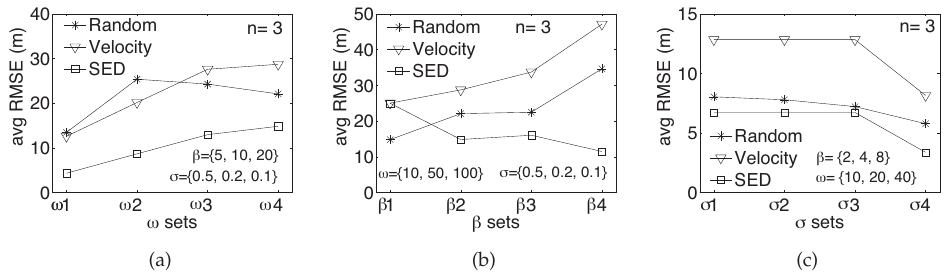
Figure 11: Average RMSE for nested evaluation of multi-scale